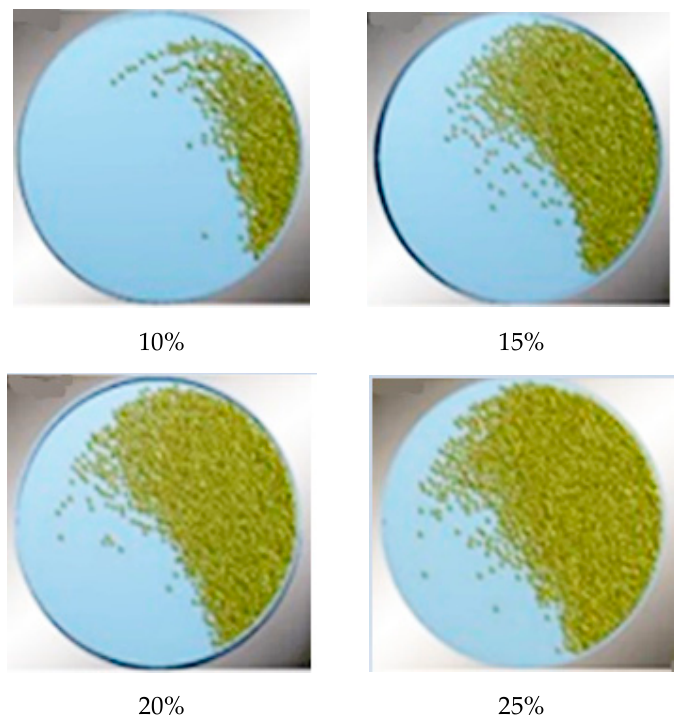
Figure 3. Motion state of pellets is 1.6 s at 0.7 N / Nc for different charge ratios.